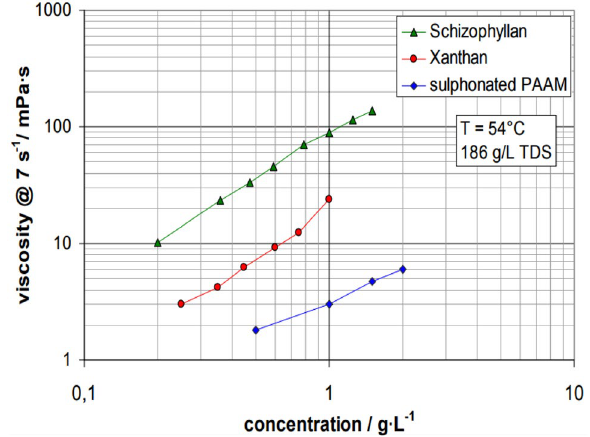
Fig. 4 Comparison of the viscosity of schizophyllan to commercial EOR Polymers (Hatscher 2016)